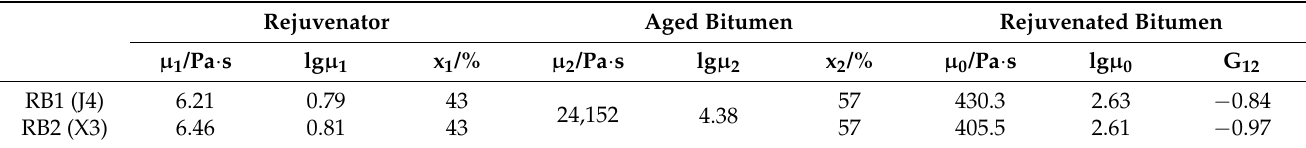
Table 11. Compatibility parameters of rejuvenated RAP bitumen.